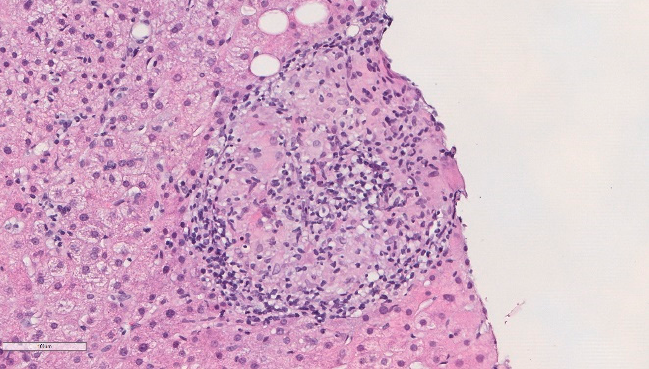
Figure 2. Histopathological findings of the liver biopsy sample revealed epithelioid granulomas (haematoxylin and eosin).